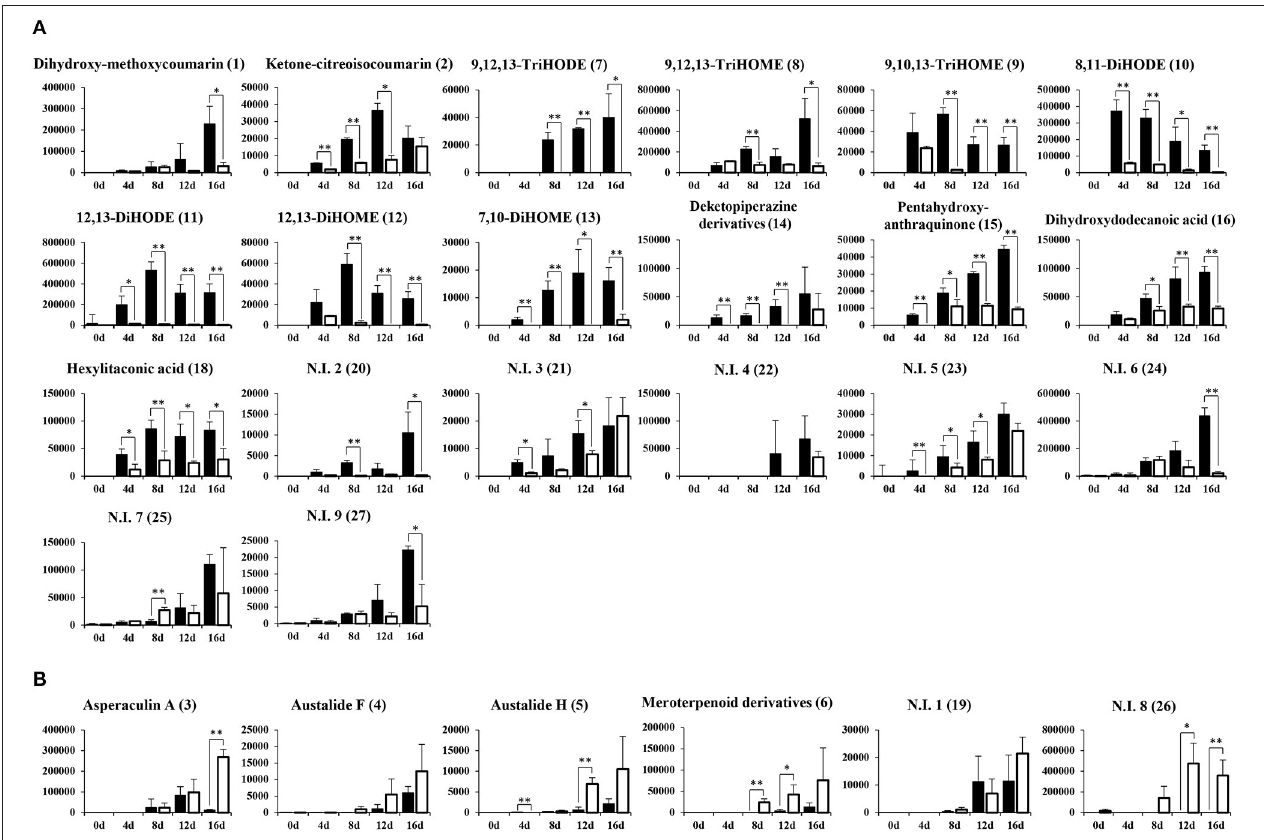
FIGURE 2 | Production of secondary metabolites from solid-state (A) and submerged (B) fermentation of A. oryzae KCCM 12698. The Y-axis of the graphs indicates peak area of each metabolite normalized by volume (100mL). Data are shown as means ± S.D. ( n = 9). Significant differences between the SSF and SmF groups were identified by t -test (* p < 0.05, ** p < 0.01). ( , Solid-state fermentation; , Submerged